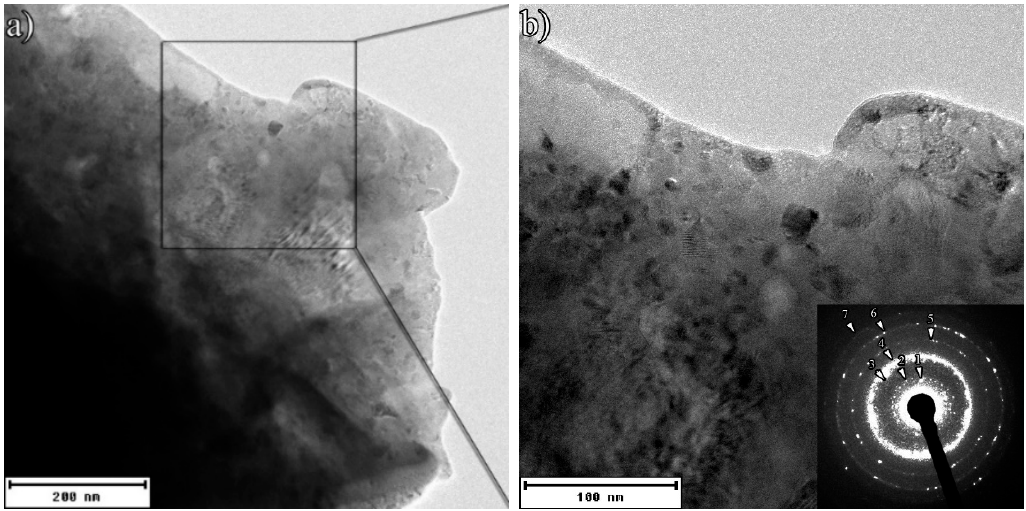
Figure 4. TEM images of the ENP coated powders after 360 min of MA at ( a ) lower and ( b ) higher magnifications.